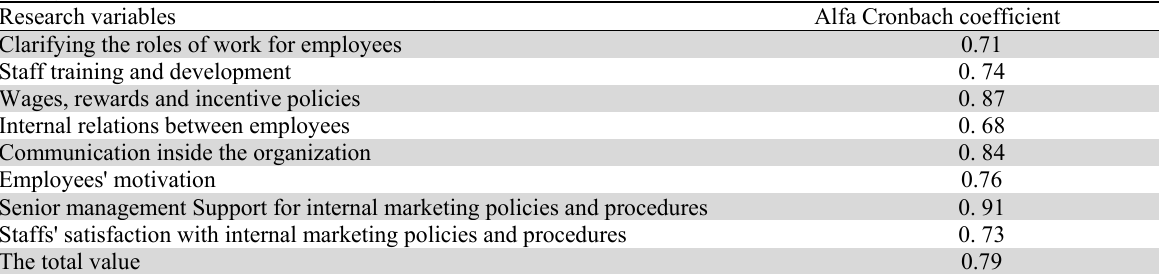
Stability coefficient Alfa Kronbach for the study variables Research variables Alfa Cronbach coefficient Clarifying the roles of work for employees 0.71 Staff training and development 0.